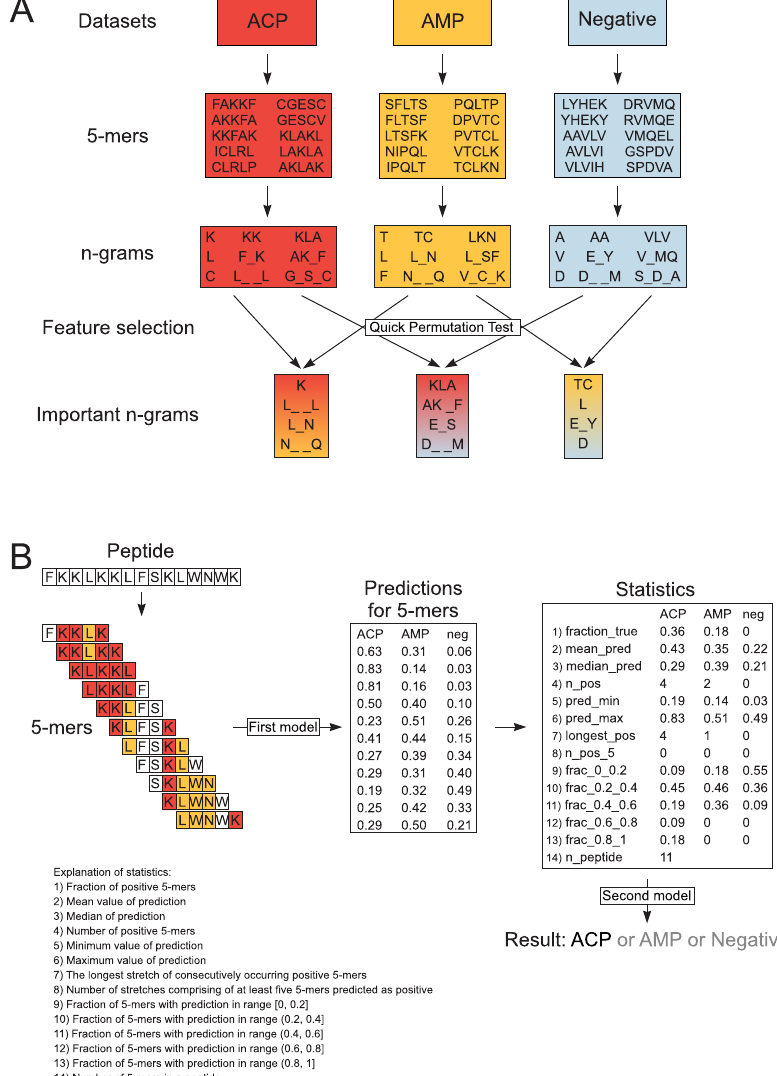
Figure 1. Schematic representation of n -gram extraction ( A ) and decision-making procedure in CancerGram ( B ). The training data sets include ACP (shaded in red), AMP (shaded in yellow) and non-ACP/non-AMP sequences (the negative data set, shaded in blue). Each peptide from the training data sets was divided into subsequences of 5 amino acids (5-mers). For each 5-mer, we extracted continuous and discontinuous n -grams of size ranging from 1 to 3, and exemplary n -grams are presented in boxes shaded in colors respective to the data sets. The informative n -grams for CancerGram training were selected by Quick Permutation Test for all combinations of the data sets, and they are shaded in: (i) red-yellow for the ACP/AMP data set, (ii) red-blue for the ACP/Negative data set, and (iii) yellow-blue for the AMP/Negative data set ( A ). To make a prediction, CancerGram first divides a peptide into 5-mers and then, for each 5-mer, makes a prediction if it is an ACP, AMP or non-ACP/non-AMP (the first model). To scale the prediction from 5-mers to the level of a peptide, numerous statistics are calculated, and on their basis, CancerGram makes the final prediction (the second model) ( B